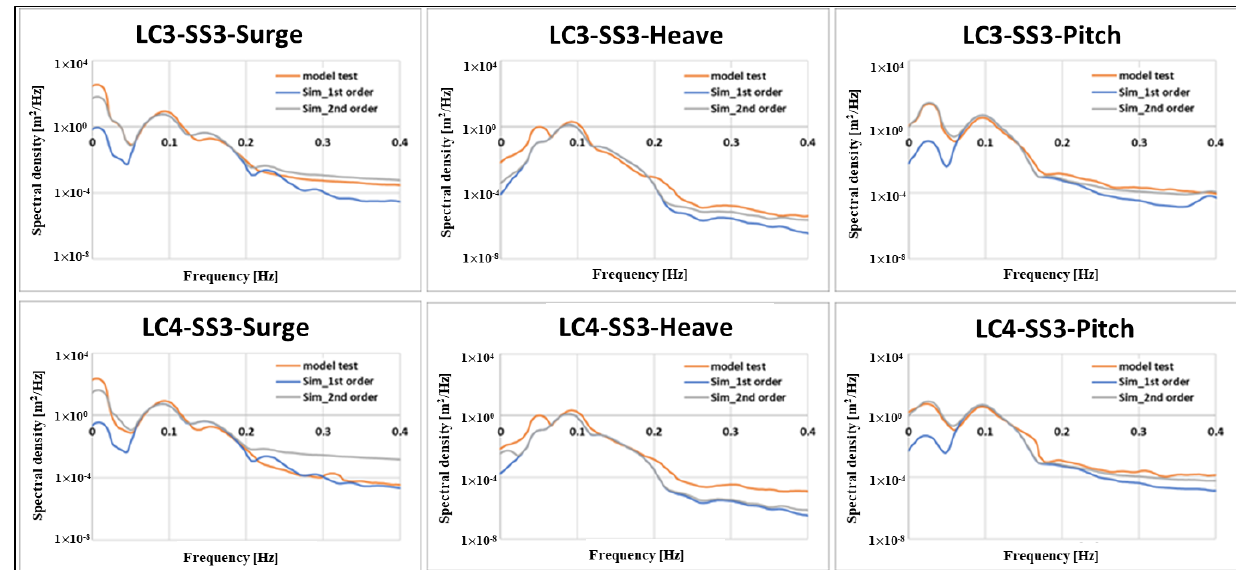
Figure 14. Sea state2: LC3 and LC4 result under irregular waves.